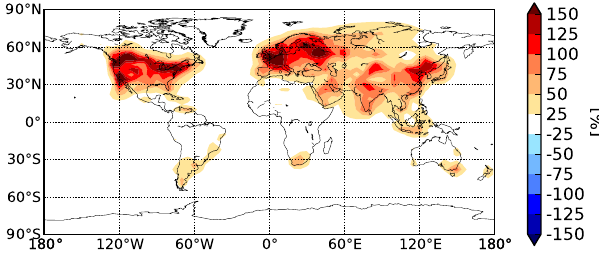
Figure 6. Change in annually averaged condensation sink between NoSGS_yXSOA_Napa and